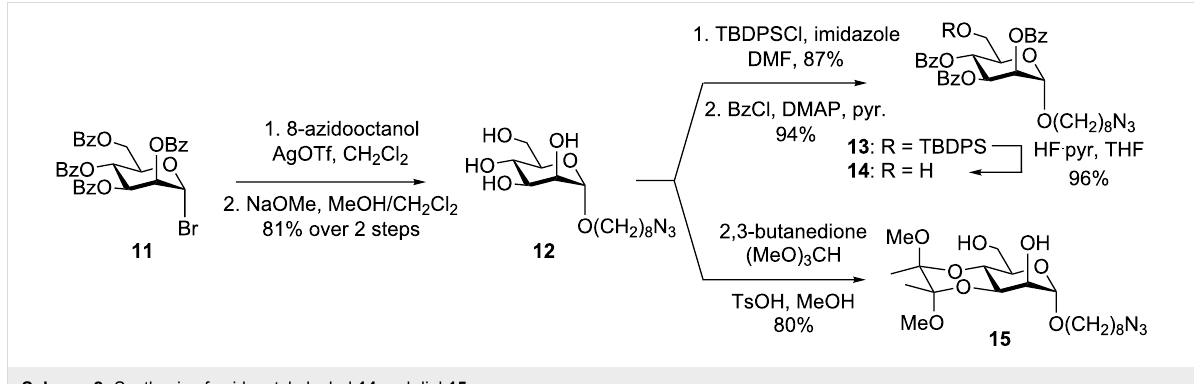
Scheme 2: Synthesis of azidooctyl alcohol 14 and diol 15